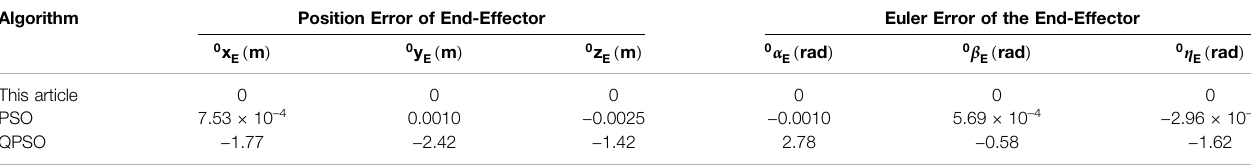
TABLE 11 | Position and orientation errors according to different